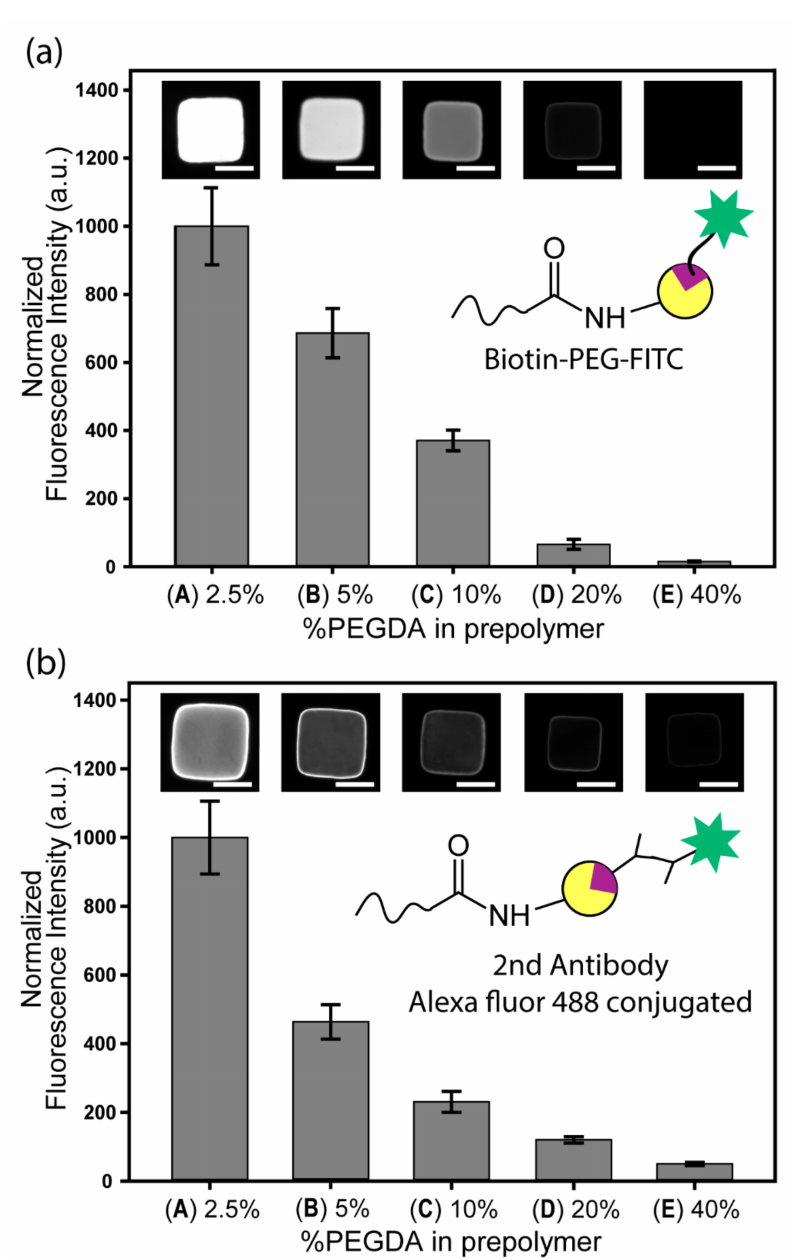
Figure 4. Characterization of fluorescence intensity obtained from NeutrAvidin proteins and antibodies in the particles: ( a ) NeutrAvidin proteins are conjugated with biotin–PEG–FITC by avidin–biotin interaction. Fluorescence intensity is normalized on the basis of group A (2.5% PEGDA in prepolymer). ( b ) Secondary fluorescence antibodies conjugated with Alexa fluor 488 are attached to the biotinylated EpCAM antibodies for quantification. Each data bar and error bar represent the average signal and standard deviation of 10–15 particles. Each image in the graph corresponds to the bar directly below. All the images are shown in same calibration profile of brightness and contrast. Scale bars are 50 µ